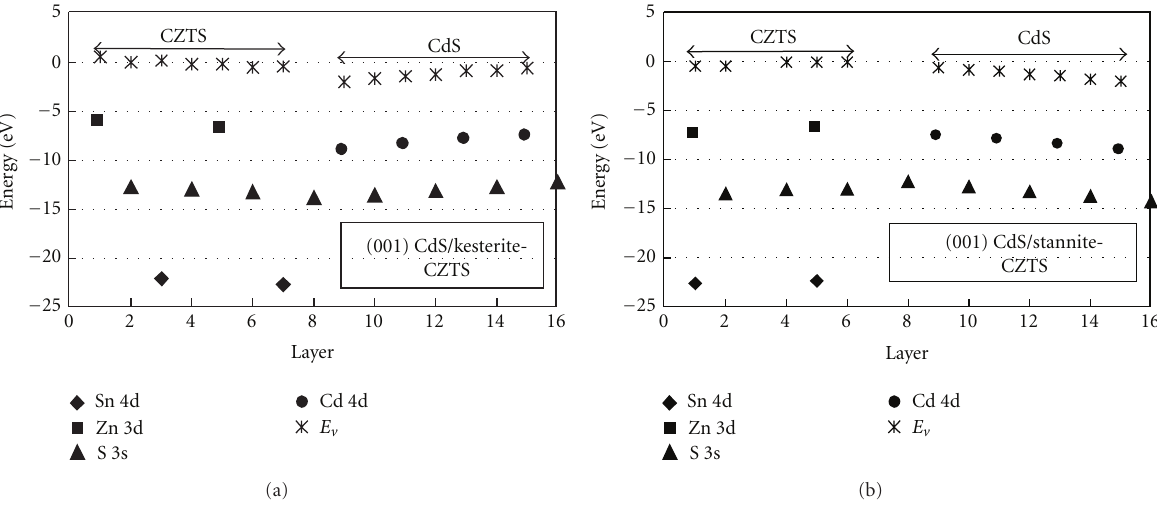
Figure 3: Calculated reference core levels and VBM for the respective layer in the (001)-oriented CdS/CZTS supercell. (a) CdS/kesterite- CZTS. (b)